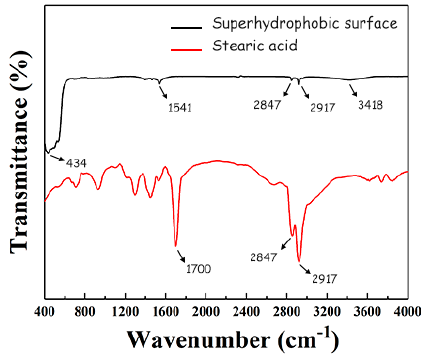
Figure 6. Diagram of the reaction mechanism of zinc oxide and stearic acid.